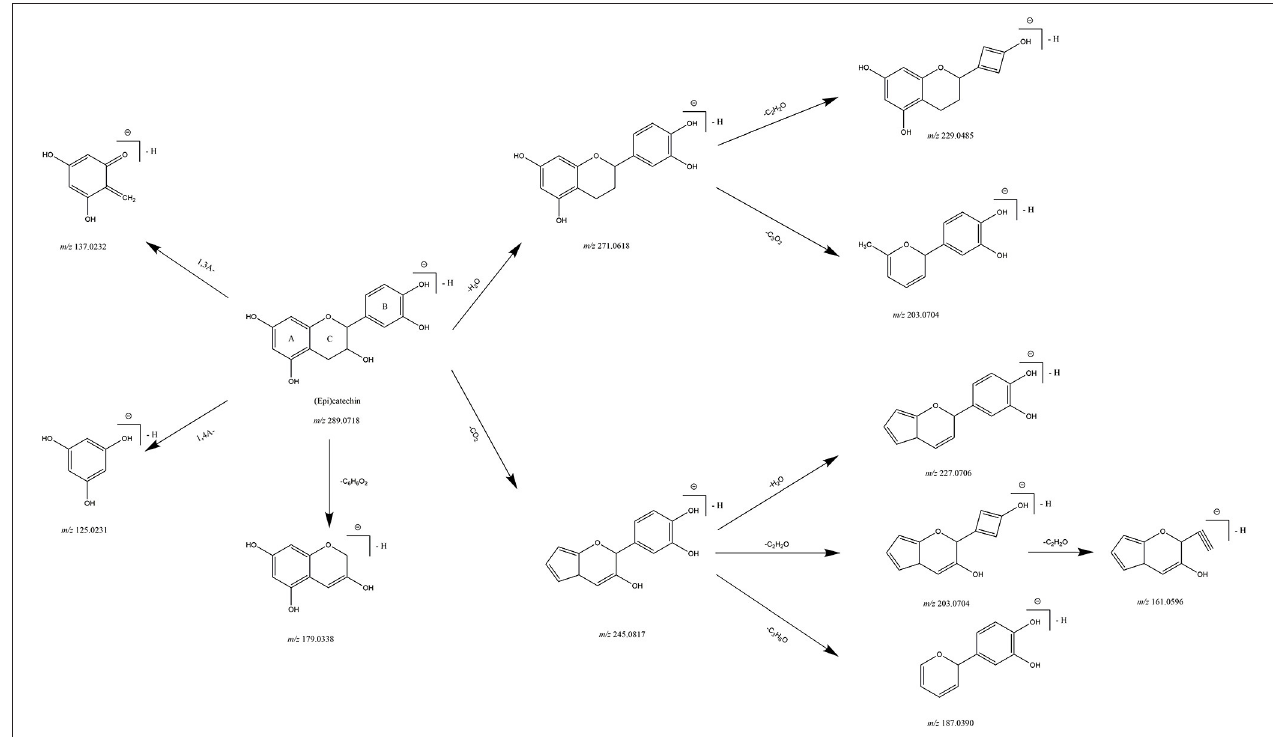
FIGURE 3 | Proposed fragmentation pathway of Catechin/Epicatechin.